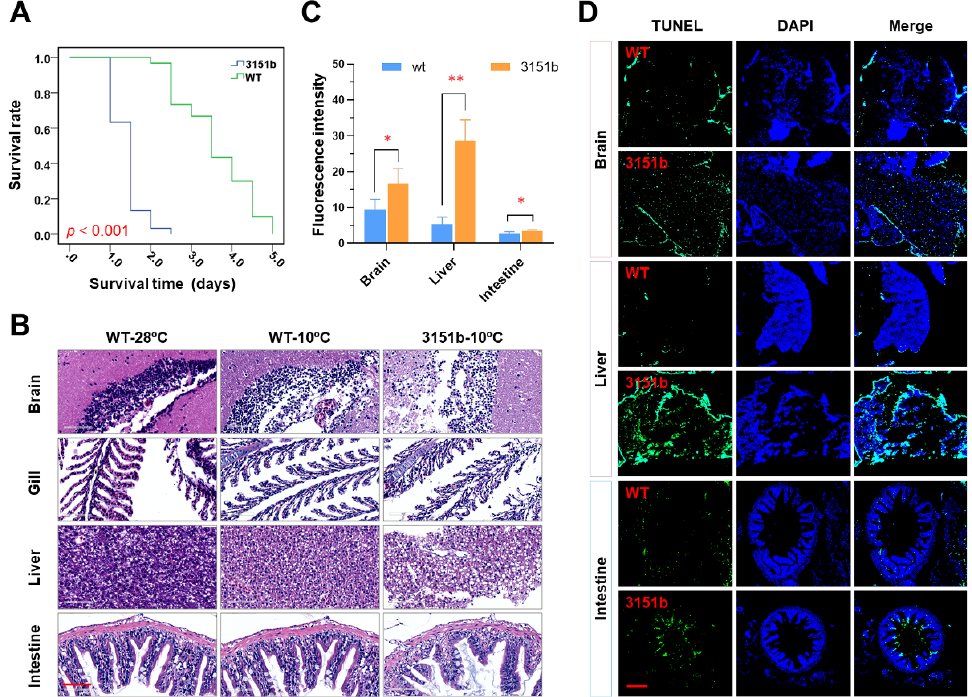
Figure 3. Dysfunction of the tmem39b gene decreases the cold resistance of adult zebrafish. ( A ) Sur ‐ vival rates of WT and zko3151b adults upon exposure to lethal cold stress. ( B ) Photos of the hema ‐ toxylin and eosin (H&E) ‐ stained tissue sections. The scale bar represents 60 μ m. ( C ) Fluorescence intensity of the TUNEL (terminal deoxynucleotidyl transferase ‐ mediated dUTP nick ‐ end ‐ labeling) ‐ stained tissue sections. *, p < 0.05; **, p < 0.01 ( n = 3). ( D ) Fluorescence images showing more severe cell apoptosis in tissues of the zko3151b mutants in comparison to the WT. The scale bar represents 150 μ m.